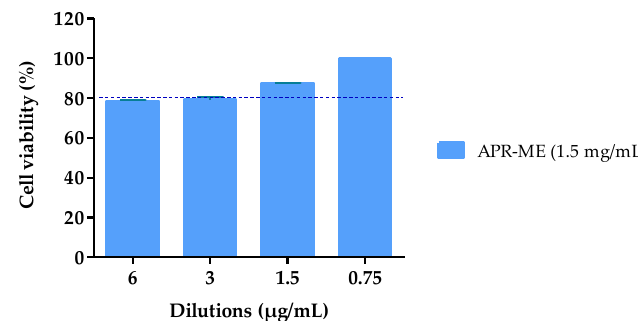
Figure 6. Percentage of cell viability of HaCaT cell line exposed to APR-ME for 24 h at different concentrations ranging from 6 to 0.75 µg/mL. Results obtained with Blank-ME indicated 100% viability.